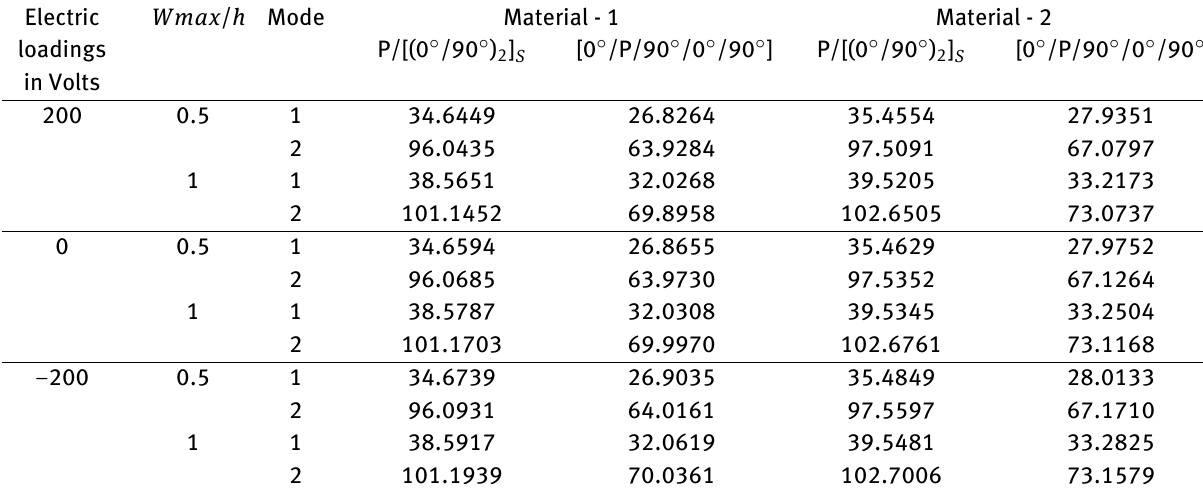
Table 11: Effect of electrical loading, amplitude ratio, frequency mode, material properties and lamination scheme on dimensionless mean nonlinear natural frequency of conical shell panel with LC / h = 100 .